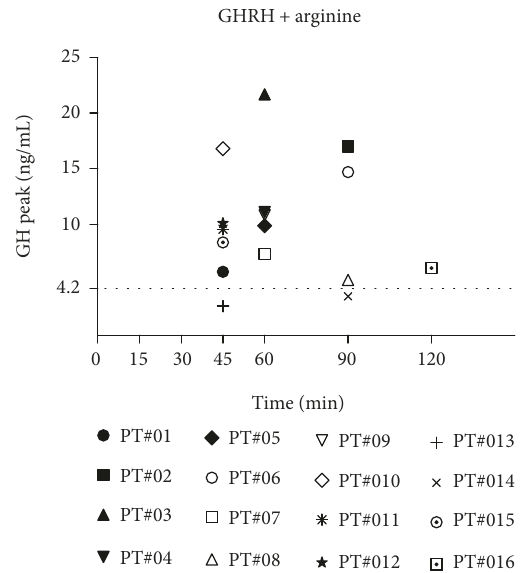
Figure 2: GH peaks obtained in each of the 16 FM obese patients who underwent the GHRH plus arginine test together with the corresponding time points (i.e., T max